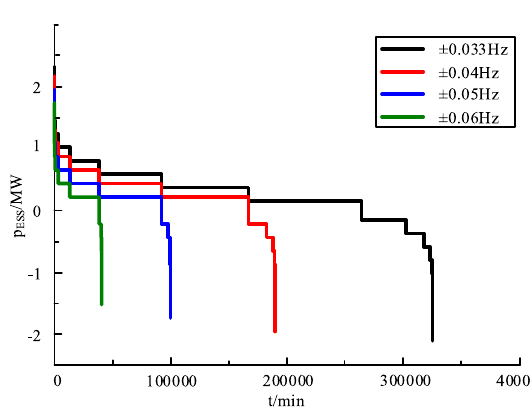
Fig. 6 Annual energy storage frequency regulation power duration curve